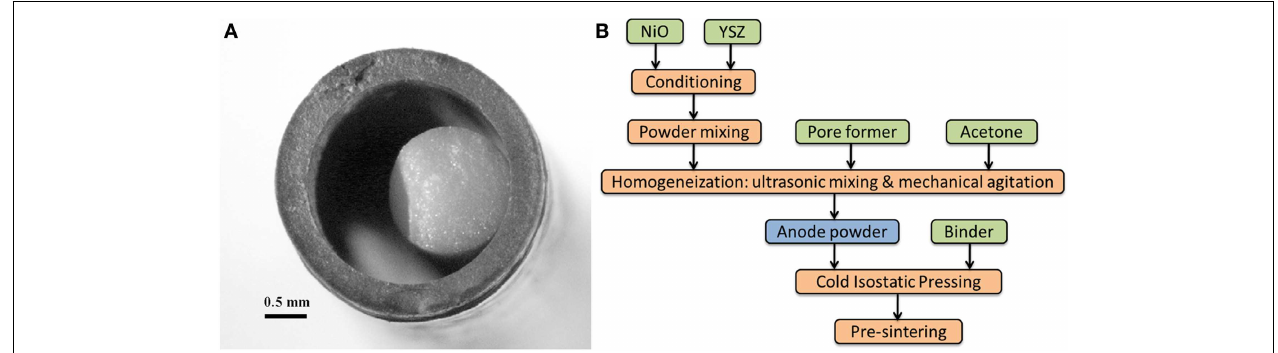
FIGURE 2 | (A) Cross-section of a NiO/YSZ tube fabricated by CIP. (B) CIP production scheme.